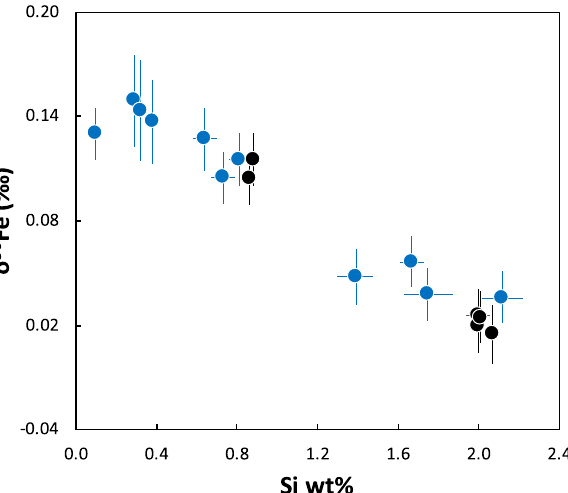
Figure 1. δ 56 Fe versus Si content of aubrite metals. Blue symbols represent metals from brecciated aubrites (Norton County and Bishopville) and black symbols show metals from non-brecciated aubrites (Shallowater and Mount Egerton). An inverse correlation between the δ 56 Fe and Si content of aubrite metals is observed. All errors are